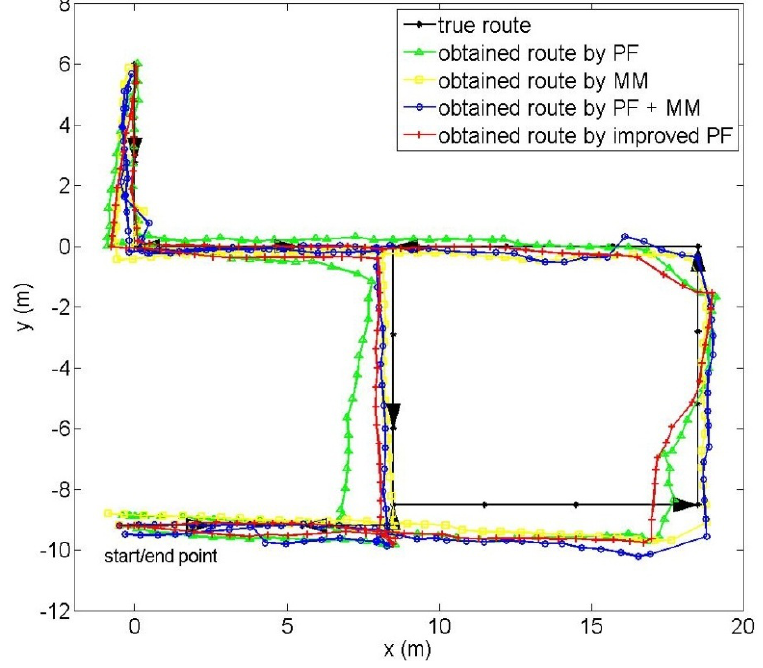
Figure 7. An example of the tracked results for route 1 and 2 given different